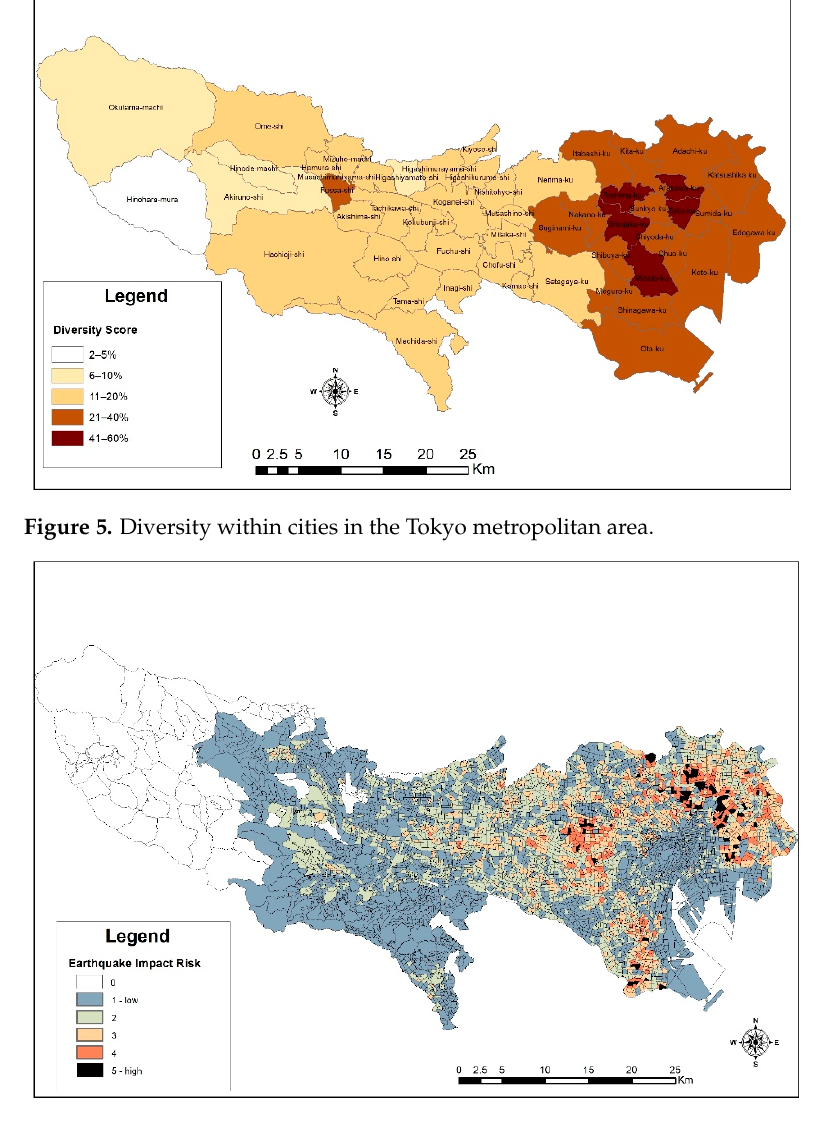
Figure 6. Earthquake impact risk assessment. Source: based on data from the Bureau of Urban Development, Tokyo Metropolitan Government ( 地震に関する地域危険度測定調査 | 東京都都市整 備局 tokyo.lg.jp (accessed 2 December 2020).